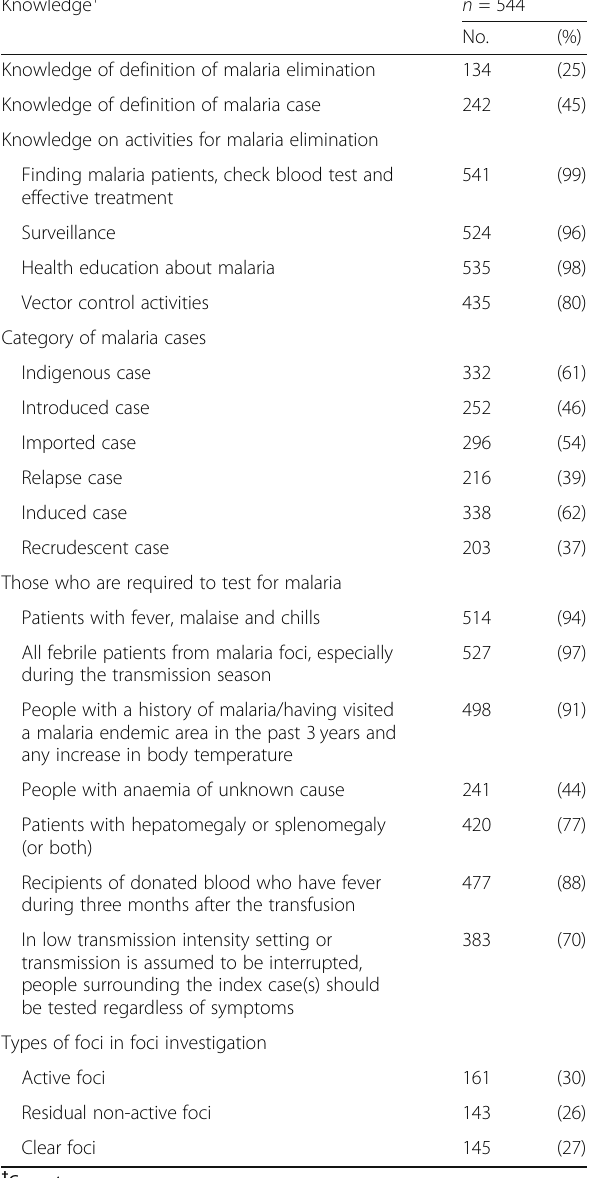
Table 2 Knowledge about malaria elimination at six targeted townships for malaria elimination, Myanmar, 2017 to